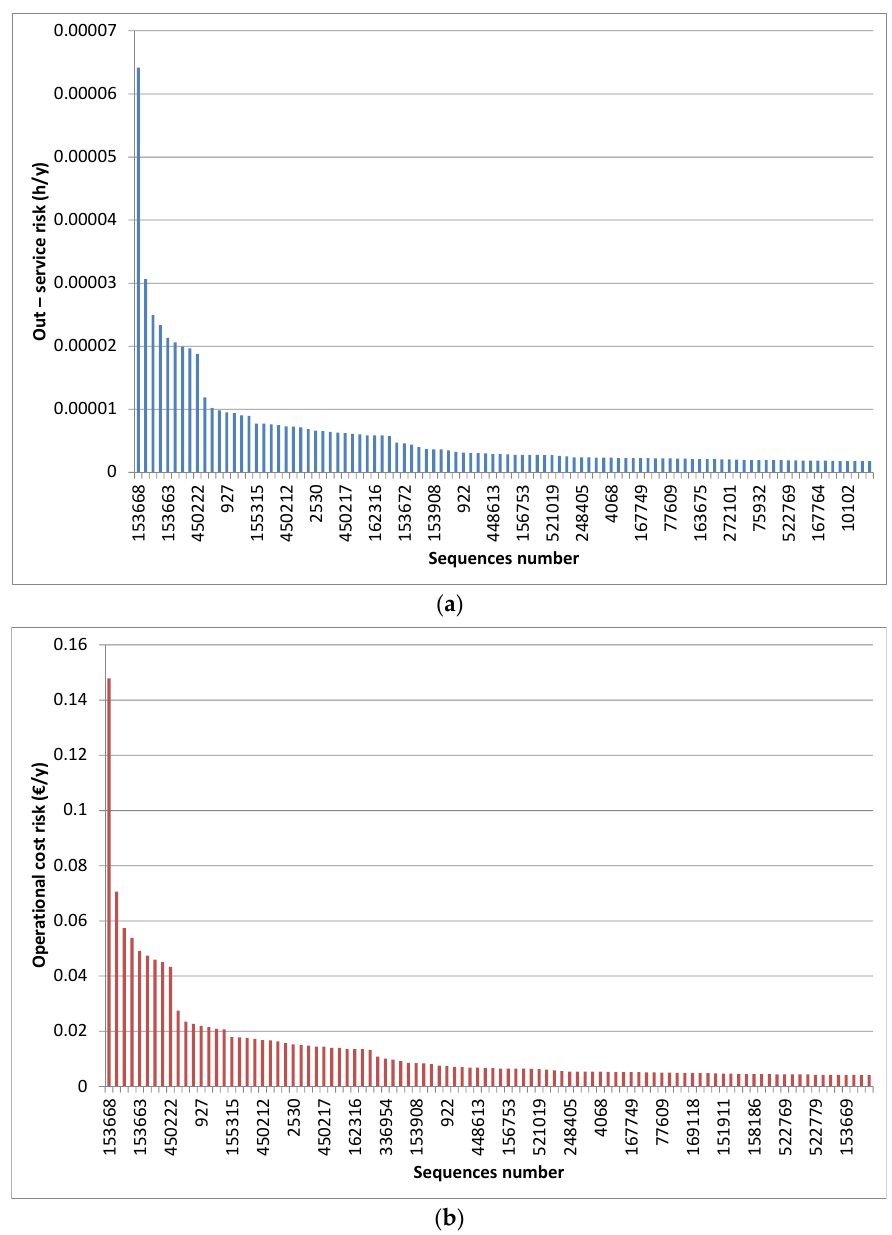
Figure 12. Details of the results bringing to the catalyst sinterization for the fixed bed based plant ( a ) The 100 sequences with the higher value of out ‐ service time risk; ( b ) The 100 sequences with the higher value of risk of operational cost. Table 4. Fixed bed plant and reverse flow plant results.